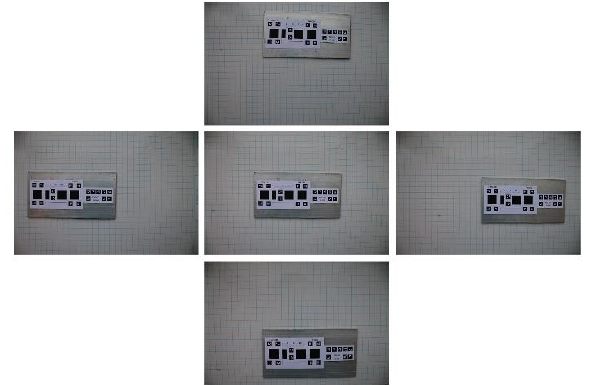
Figure 7. Photos of the PMC-1D marker in different parts of the frame.